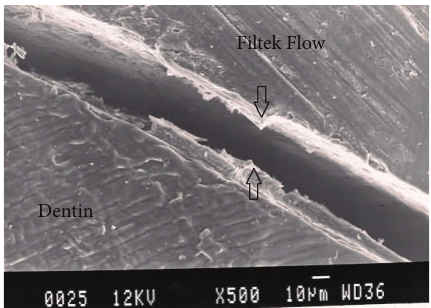
Figure 4: Representative SEM photomicrograph of a Group 4 spec- imen (Filtek Flow + Filtek Z250, light-cured together). The arrows indicate microgap formation between Filtek Flow and dentin.